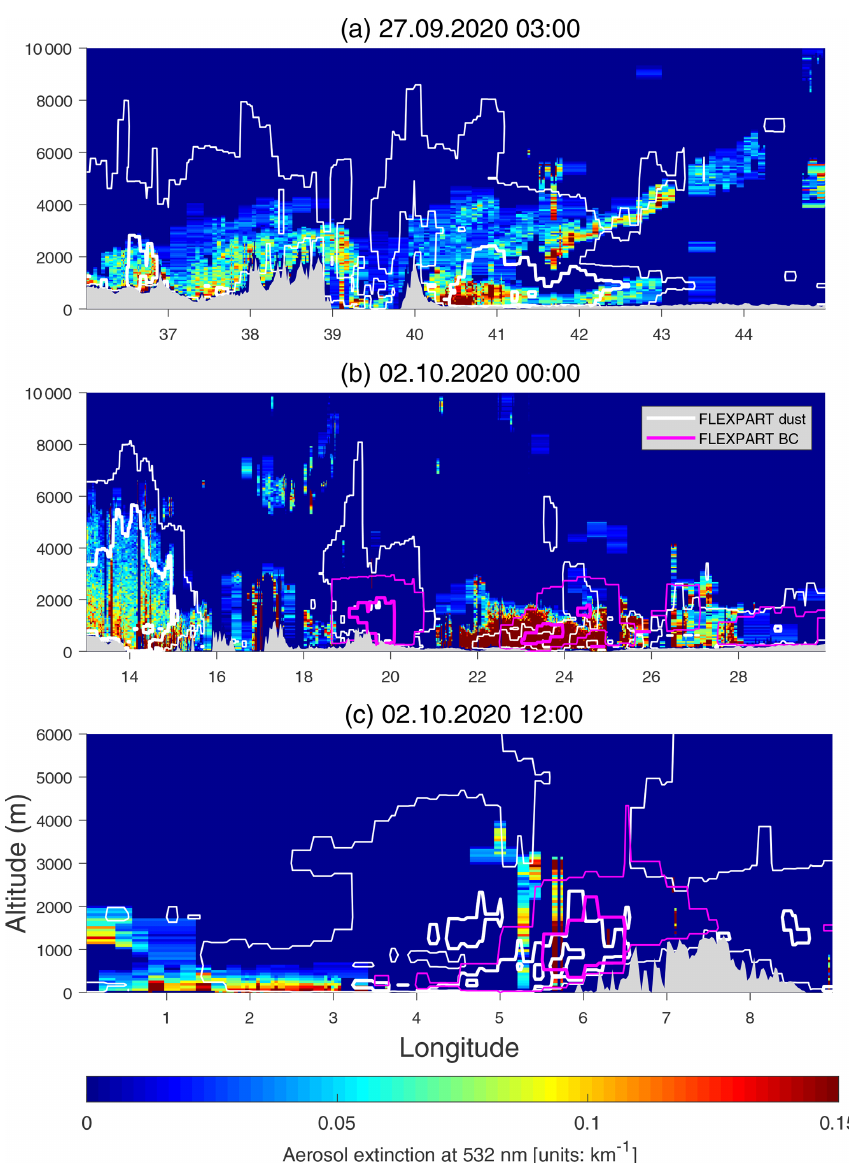
Figure 6. Aerosol extinction at 532nm [units: km − 1 ] during three overpasses (see Fig. 5 for location) is shown as colour plot ( a : CALIOP overpass from 26 September 2020, time of first record 23:48; b : 2 October 2020, time of first record 01:18; and c : 2 October 2020, time of first record 11:55). The titles of panels (a) – (c) indicate the FLEXPART 3-hourly time step corresponding to the overpass. White contours show FLEXPART mineral dust concentrations (thick and thin lines; a : 40 and 6µgm − 3 ; b : 50 and 10µgm − 3 ; c : 15 and 3µgm − 3 ). Magenta contours show FLEXPART BC concentrations (thick and thin lines; a : none; b : 50 and 5ngm − 3 ; c : 40 and 10ngm − 3